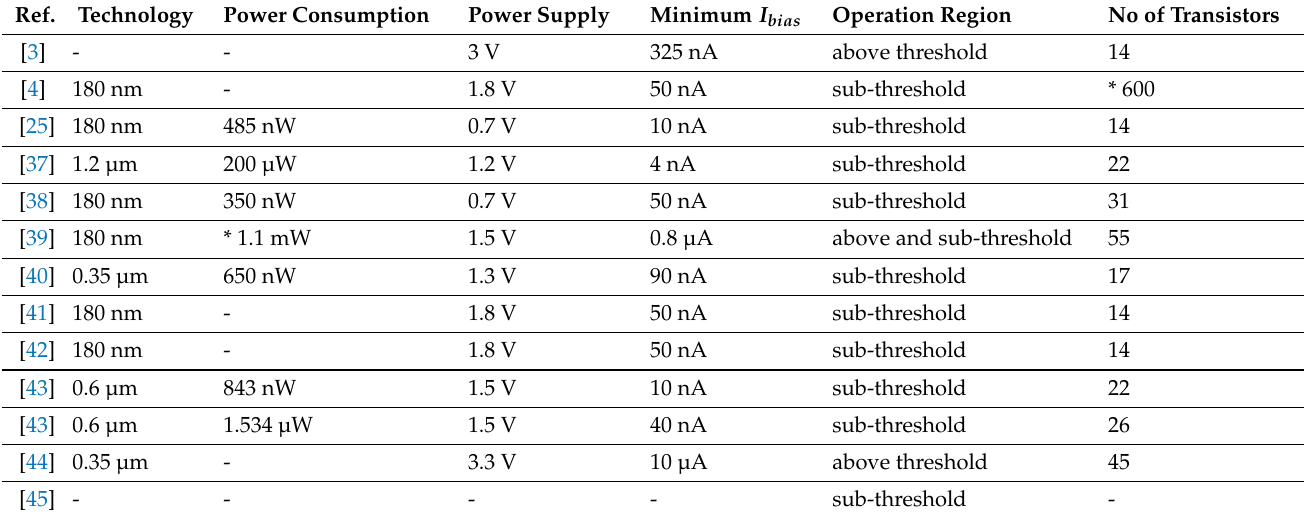
Table 1. Gaussian Function Circuits based on the translinear principle. * For the entire system. Ref.